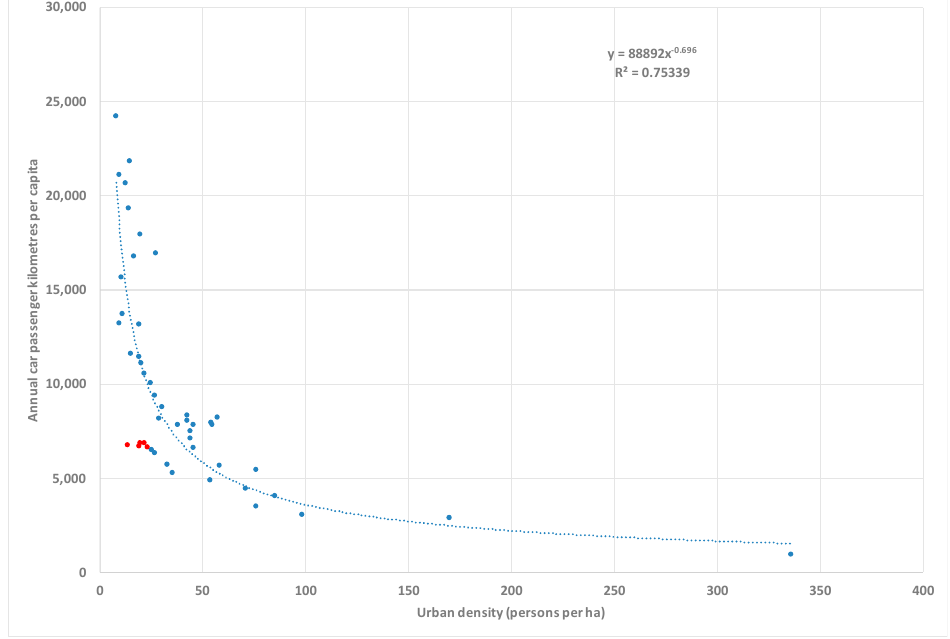
Figure 20. Annual car passenger kilometres per person versus urban density in a global sample of 48 cities (Swedish cities, 2015 in red, remainder of data, 2005–2006).